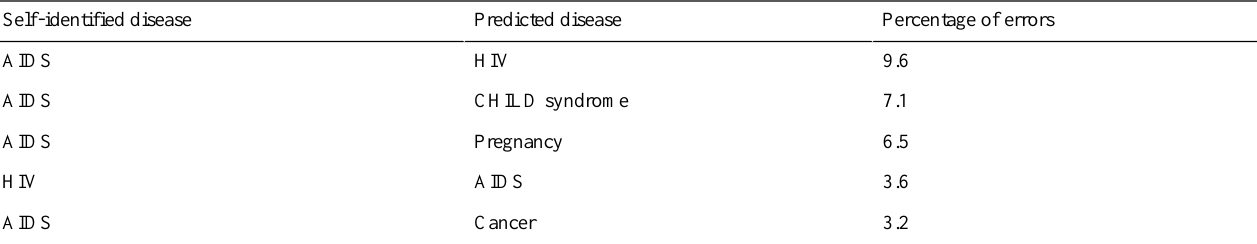
Table 3. Five most common errors of the classifier, which predicts SIUs given the disease profile.